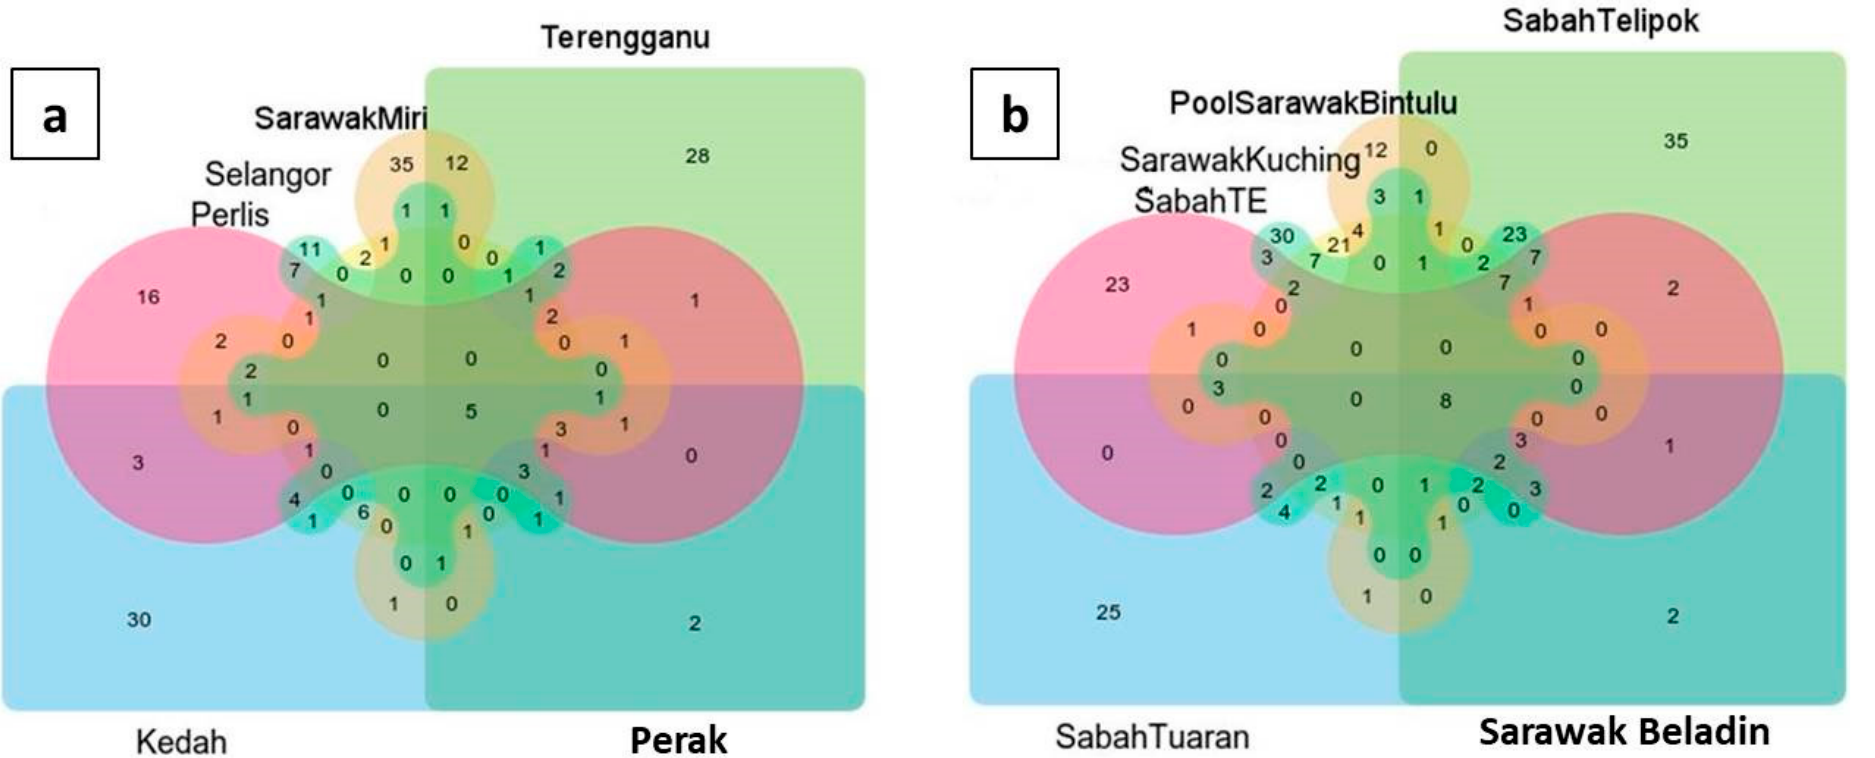
Figure 6. Venn diagrams summarizing the number of shared plant species among different locations. ( a ) Shared plant species between Sarawak and Peninsular Malaysia (Terengganu, Kedah, Perak, Perlis, Selangor). ( b ) Shared plant species between Sabah (Sabah Telipok, Sabah TE, and Sabah Tuaran) and Sarawak (Sarawak Beladin, Pool Sarawak Bintulu, and Sarawak Kuching).